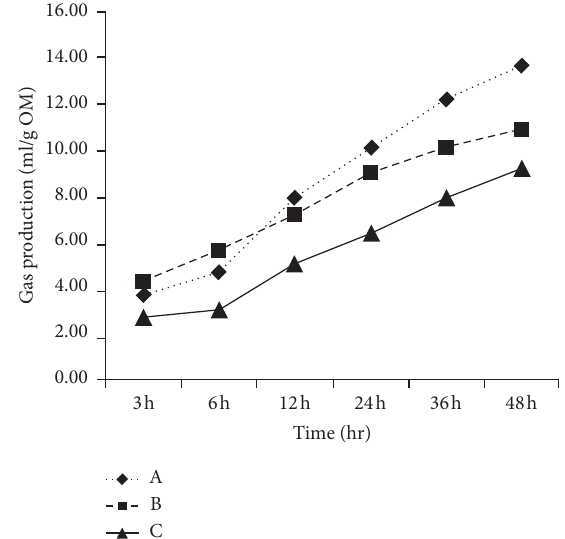
Figure 1: Volume (ml/g Organic matter) of cumulative gas pro- duced when predigested diets were incubated with intestinal contents at different incubation times, where A � ZL0, B � ZL10), and C � ZL20); ZL0: control group, ZL10: 10 g ZL/kg, and ZL20: 20g ·